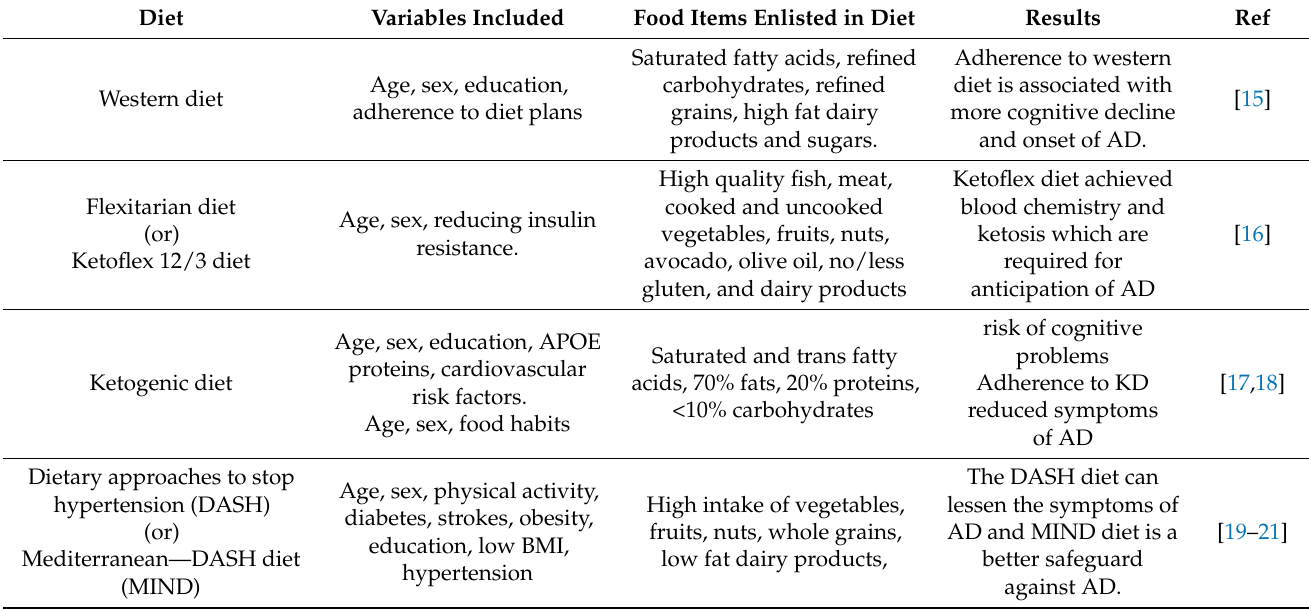
Table 1. Dietary plans and its